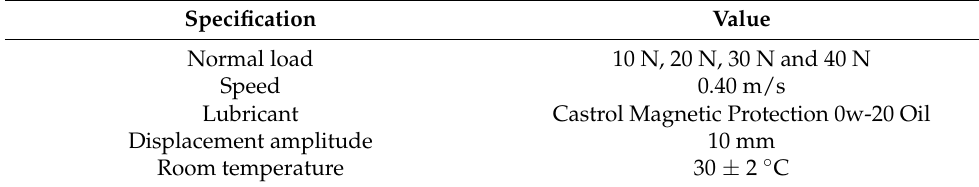
Table 2. Friction test conditions.